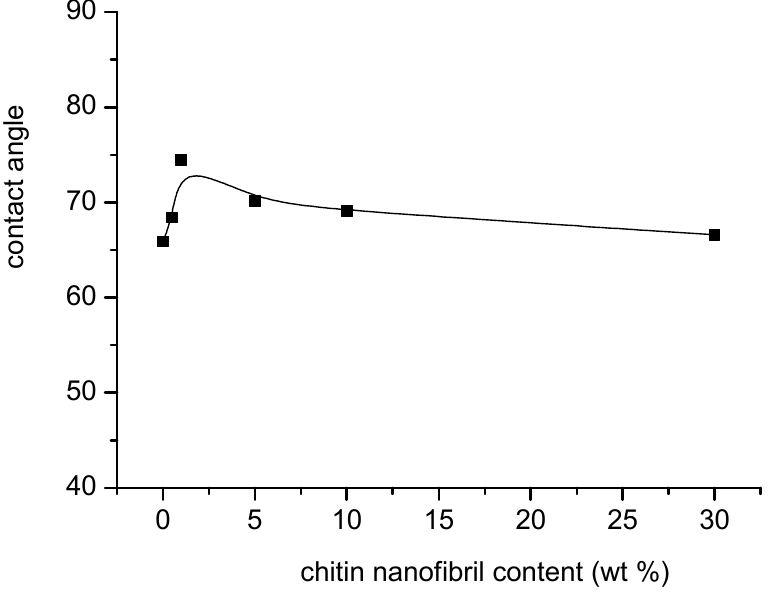
Figure 3. Dependence of the water contact angle on the chitin nanofibrils content of chitosan-based composite films.